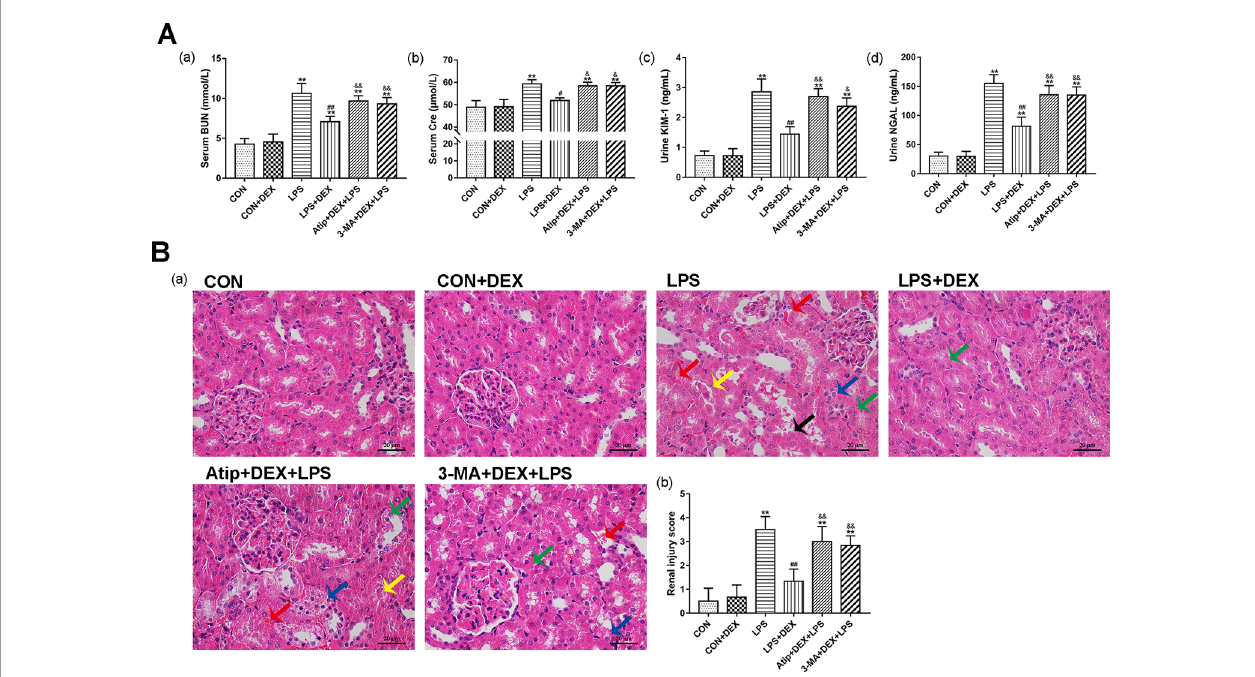
FIGURE 1 | Protective effect of DEX in LPS-induced AKI. (A) DEX improved renal dysfunction in LPS-induced AKI: the levels of serum BUN (a), serum Cre (b), urine KIM-1 (c), and urine NGAL (d) in rats. (B) Histopathological examination of the kidney: (a) Representative images from different groups. Green arrow indicates edema of renal tubular epithelial cells; blue arrow indicates tubular necrosis; yellow arrow indicates cast formation; red arrow indicates hemorrhage. Magni fi cation: 400×, Bar: 20 m m. (b) Semiquantitative histopathological score of injury. Data are expressed as mean ± SEM (n = 6). **p < 0.01 versus CON group. #p < 0.05, ##p < 0.01 versus LPS group. &p < 0.05, &&p < 0.01 versus DEX + LPS